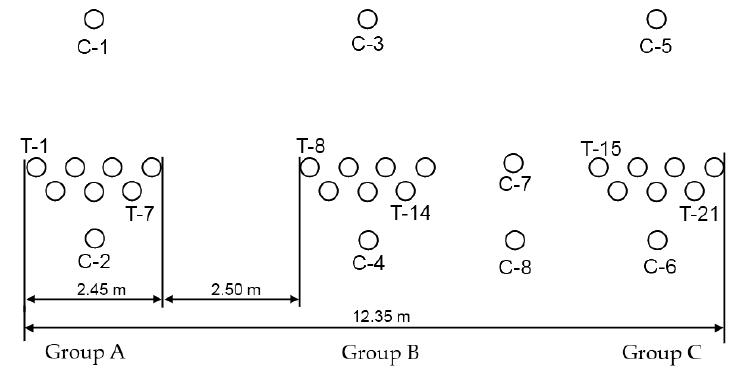
Figure 4. Scheme of PRB holes. Group A—cylinders filled with inorganic active filling; Group B—with organic-inorganic active filling; Group C—with organic active filling.